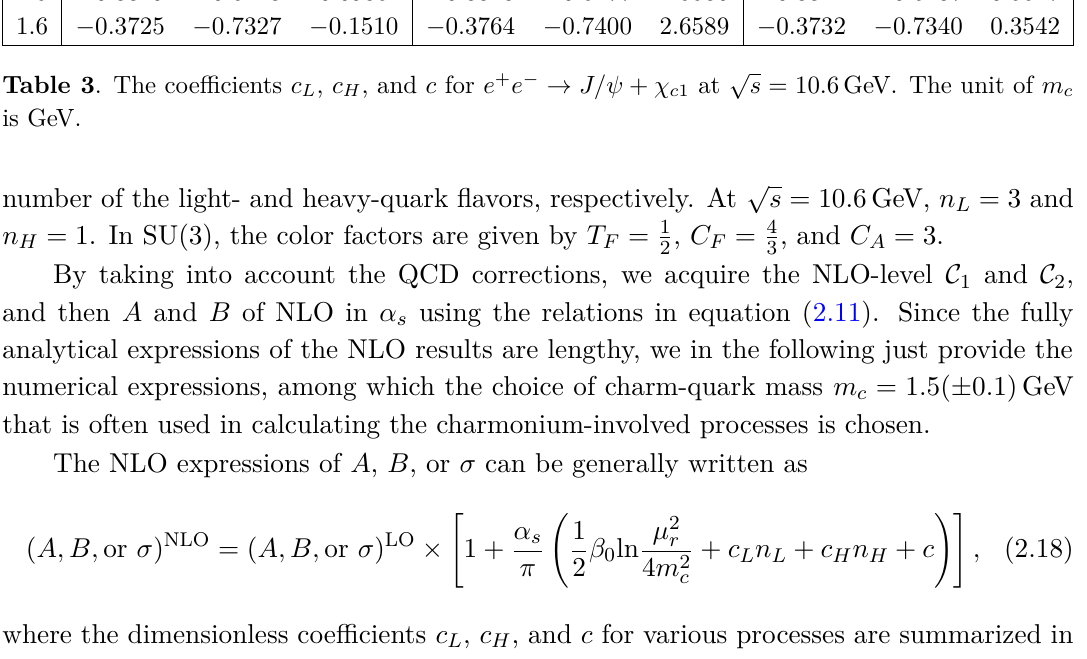
√ s = 10 . 6 GeV. The unit of m c